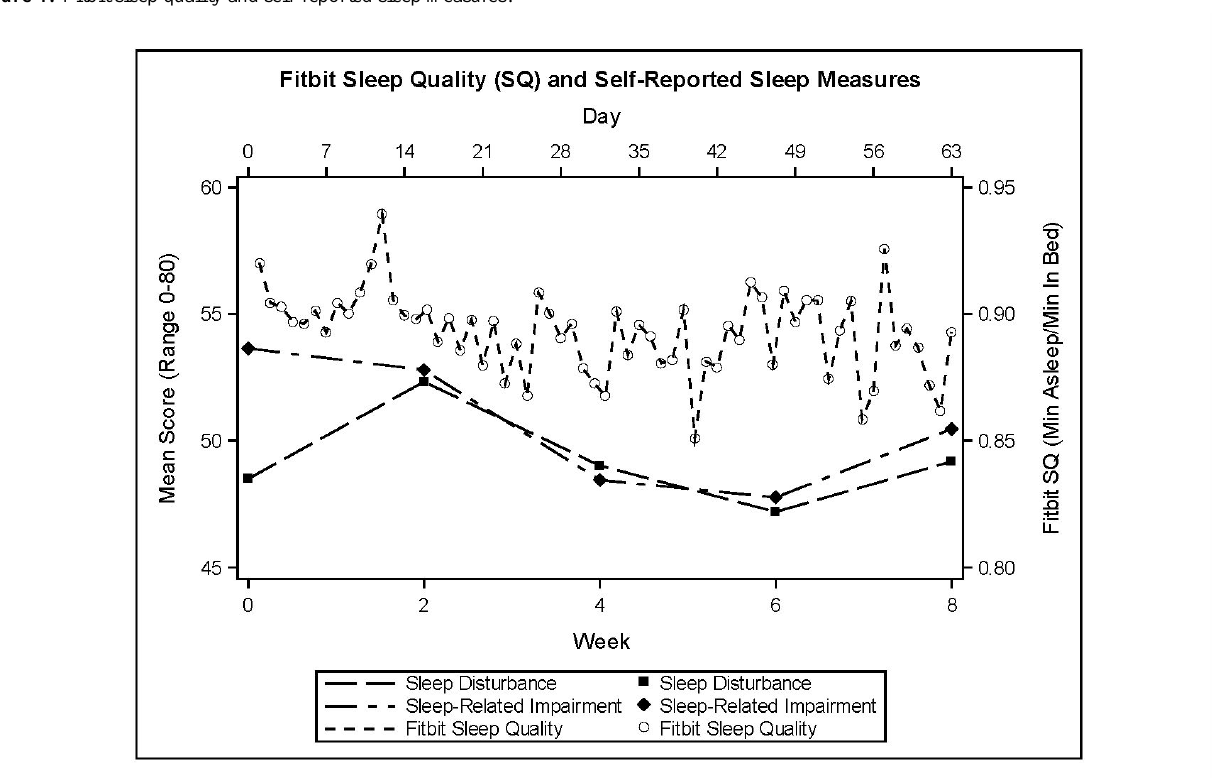
Figure 4. Fitbit sleep quality and self-reported sleep